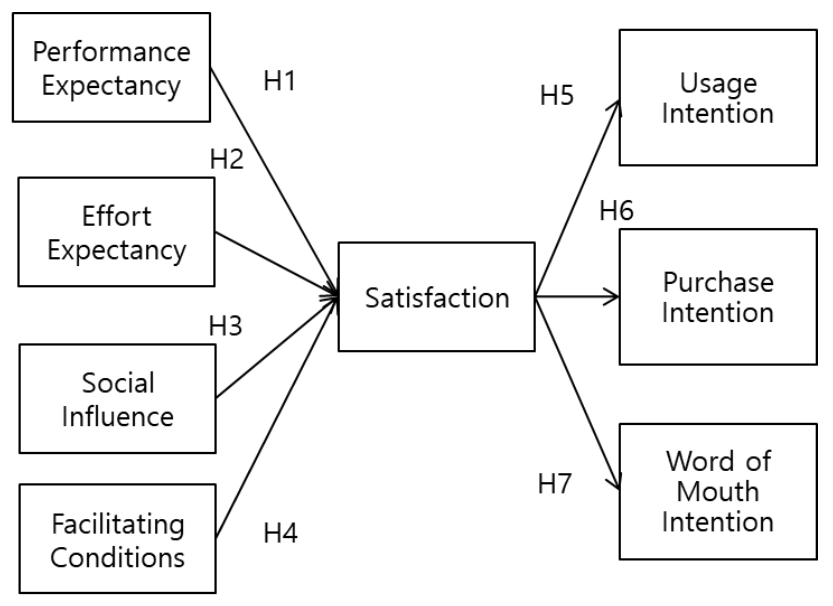
Figure 1. Research